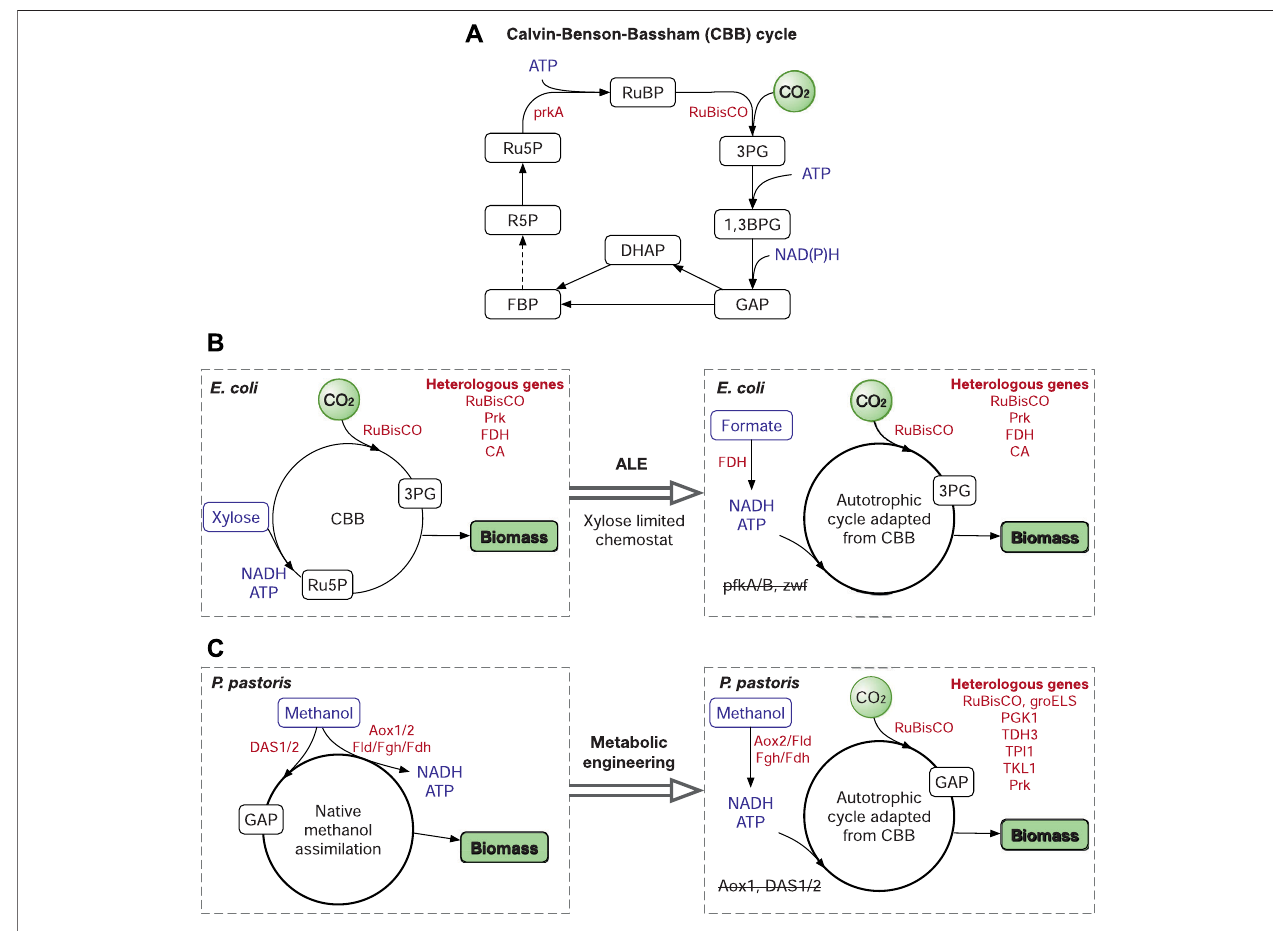
FIGURE2| TheCalvin-Benson-Bassham(CBB) cycleand itsapplicationinmetabolicengineering. (A) Thesimpli fi ed CBBcycle. (B) Autotrophic E.coli harnessing the CBB cycle. (C) The CBB-enabled synthetic autotrophic P. pastoris . Enzymes: RuBisCO, ribulose-1,5-bisphosphate carboxylase/oxygenase; PrkA or Prk, phosphoribulokinase; FDH, formate dehydrogenase; CA, carbonic anhydrase; PfkA/B, 6-phosphofructokinase; Zwf, glucose-6-phosphate dehydrogenase; Aox1/2, alcohol oxidase; DAS1/2, dihydroxyacetone synthase; Fld1, formaldehyde dehydrogenase; Fgh, S-formylglutathione hydrolase; PGK1, phosphoglycerate kinase; TDH3, glyceraldehyde-3-phosphate dehydrogenase; TPI1, triosephosphate isomerase; TKL1, transketolose. Metabolites: RuBP, ribulose-1,5-bisphosphate; Ru5P, ribulose-5-phosphate; 3PG, 3-phosphoglycerate; 1,3BPG, 1,3-diphosphoglycerate; GAP, glyceraldehyde-3-phosphate; DHAP, dihydroxyacetone phosphate; FBP, fructose1,6-bisphosphatase;R5P,ribose5-phosphate.Reducedfeedstocks(methanol,formate,xylose)andcofactors(ATP,NAD(P)H)areinblue.Genes/enzymesare in